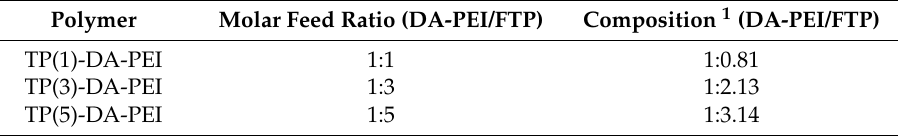
Table 1. The nomenclatures and compositions of TP-DA-PEI